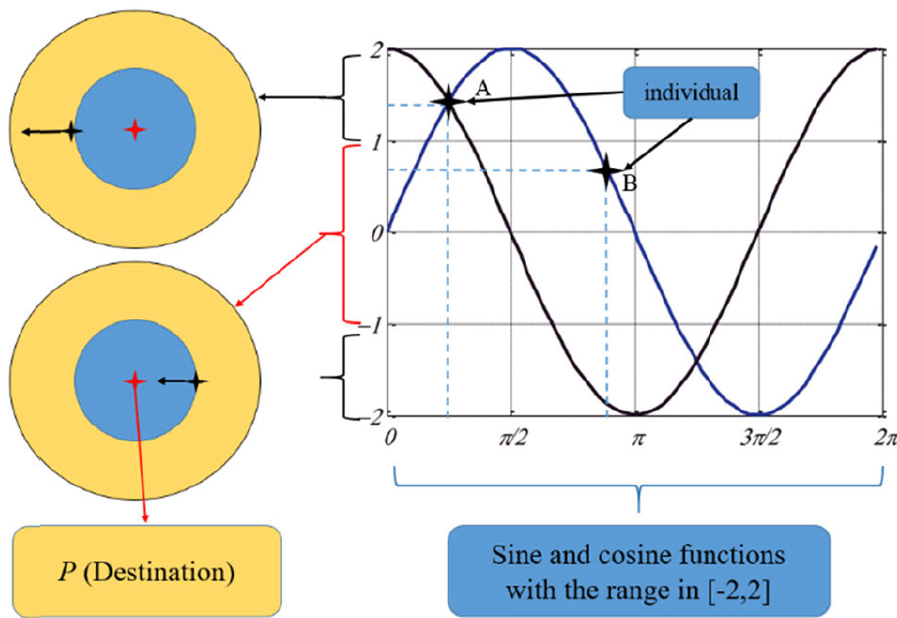
Figure 3. Tolerance given to the solutions that proceed in either direction toward or away from the destination for sine and cosine functions